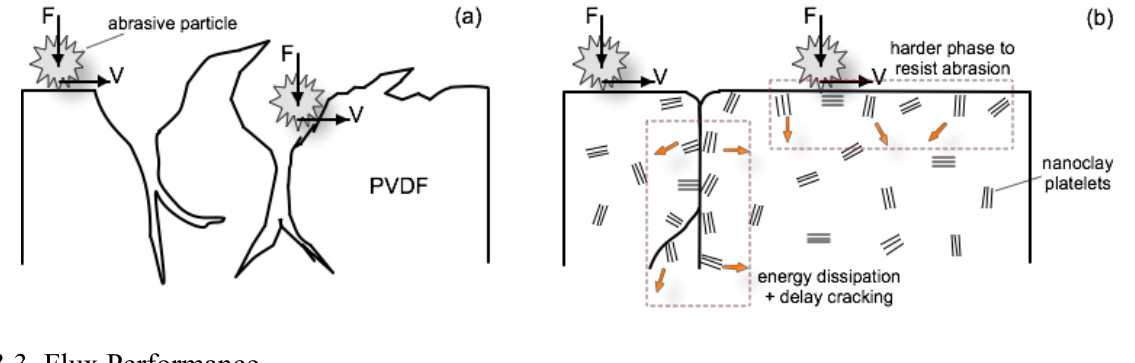
Figure 8. Proposed model for abrasion of ( a ) unmodified membrane and ( b ) the mechanically stabilized PVDF/nanoclay membrane (Reprinted with permission from [86]. Copyright 2014